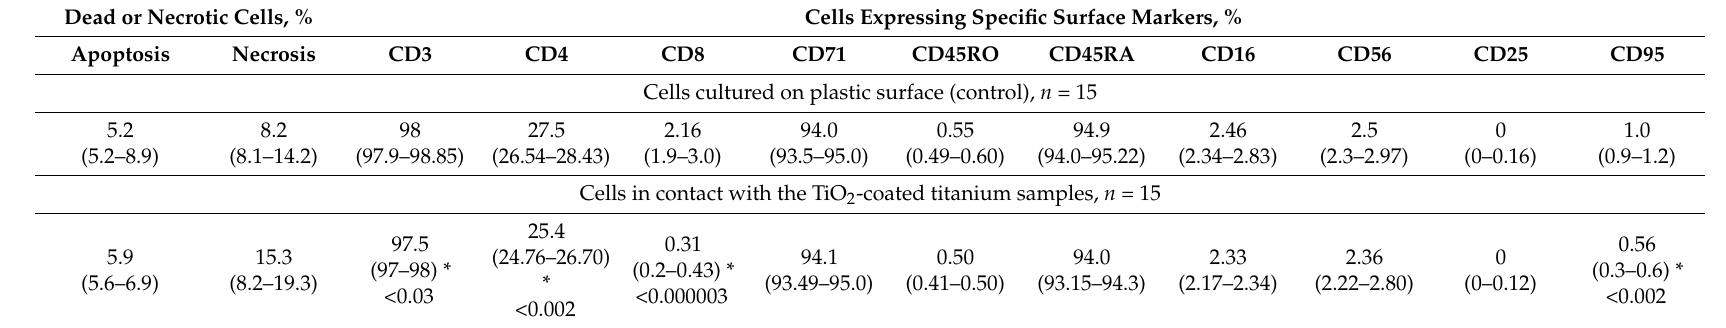
Table 4. Membrane molecular markers and death indices of Jurkat T cells after 24 h of culture in the presence of the TiO 2 coating Me (Q 1 –Q 3